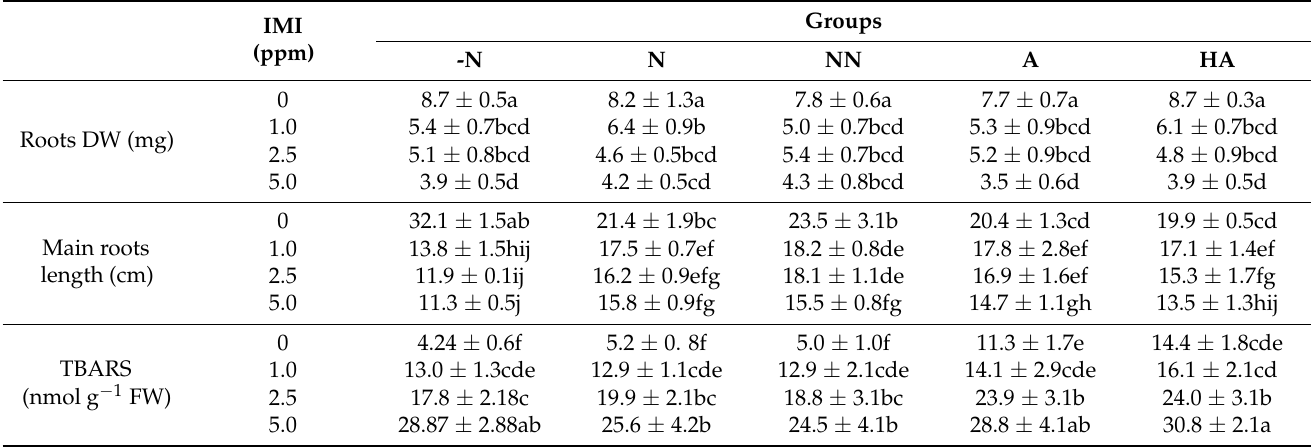
Table 2. Effect of IMI on root length, dry weight (DW) and thiobarbituric acid-reactive substance (TBARS) in maize subjected to different nitrogen treatments when exposed to different IMI levels